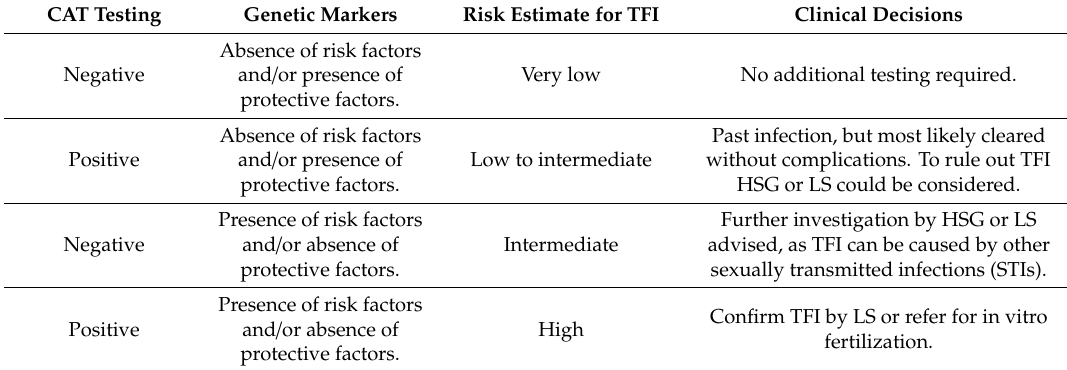
Table 2. Proposed hypothetical screening model for tubal factor infertility (TFI) based on results of the combined serological Chlamydia IgG antibody test (CAT) and genetic marker (SNP) test, and recommendations for additional testing by hysterosalpingography (HSG) or laparoscopy (LS). CAT and the host genetic marker assay are both non-invasive tests for which a small quantity of blood is needed. Combining CAT and genetic marker test in the initial phases of the infertility investigation may allow for assessing the risk of tubal pathology at an early